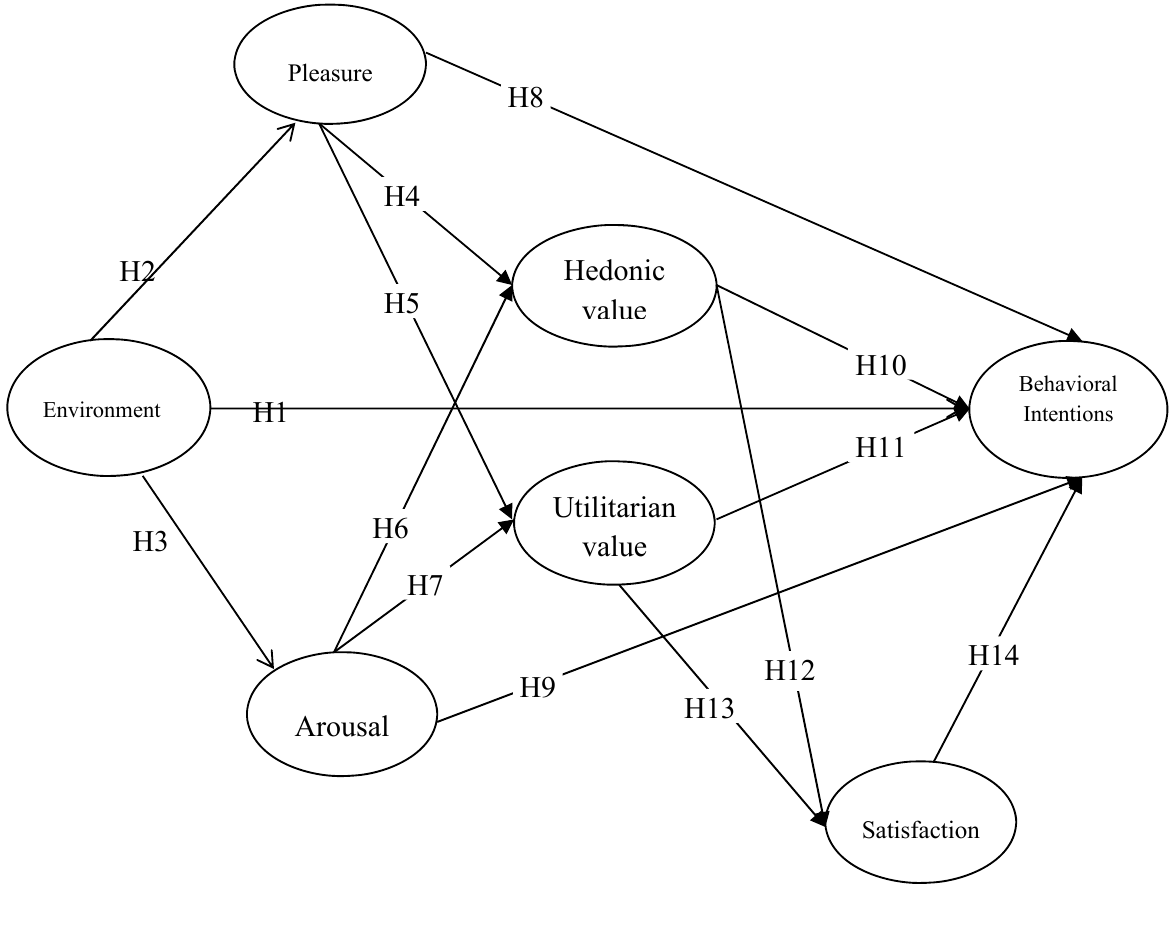
Fig. 1. Research conceptual